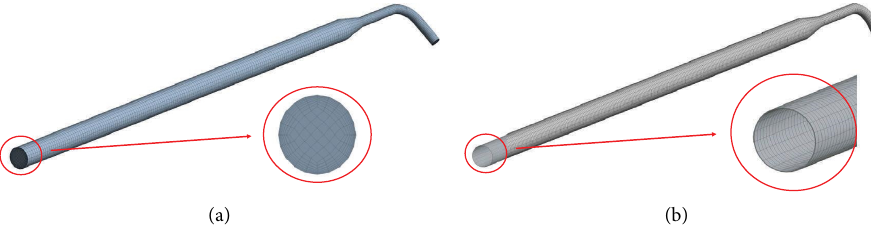
Figure 8: Schematic diagram of the grid division of pipeline structure. (a) Solid-domain meshes. (b) Fluid-domain